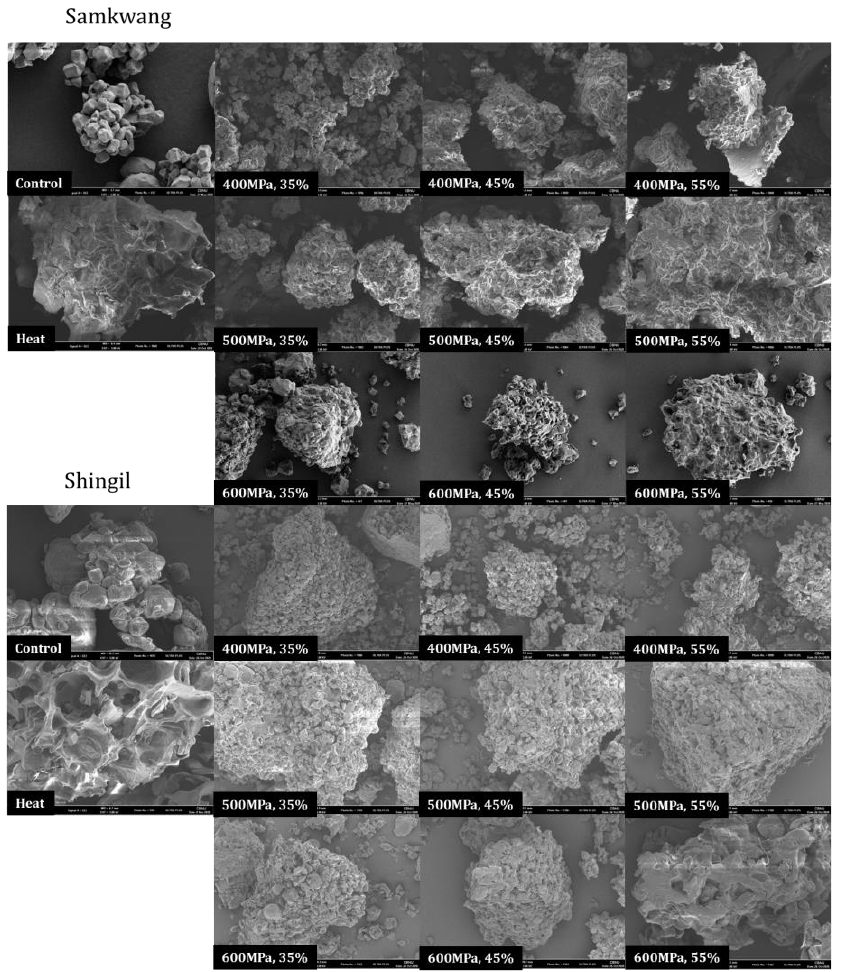
Figure 4. Scanning electron microscopy (2000×) of Samkwang and Shingil variety rice flour at different high hydrostatic pressure treatments and moisture content. 35 – 55%: Moisture content (%), 400 – 600 MPa: Pressure